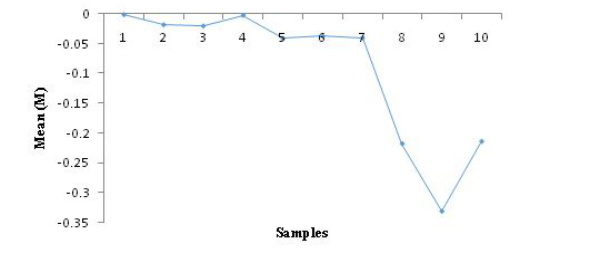
Figure 6: Mean values (M) of the different samples